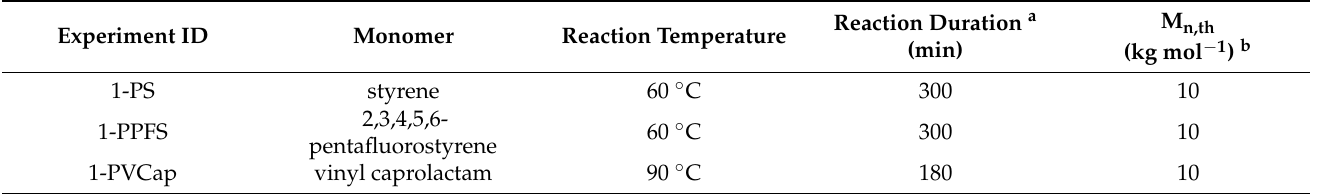
Table 1. Experimental reaction conditions for polymerization of 1-poly(styrene) (1-PS), 1-poly(2,3,4,5,6-pentafluorosty-